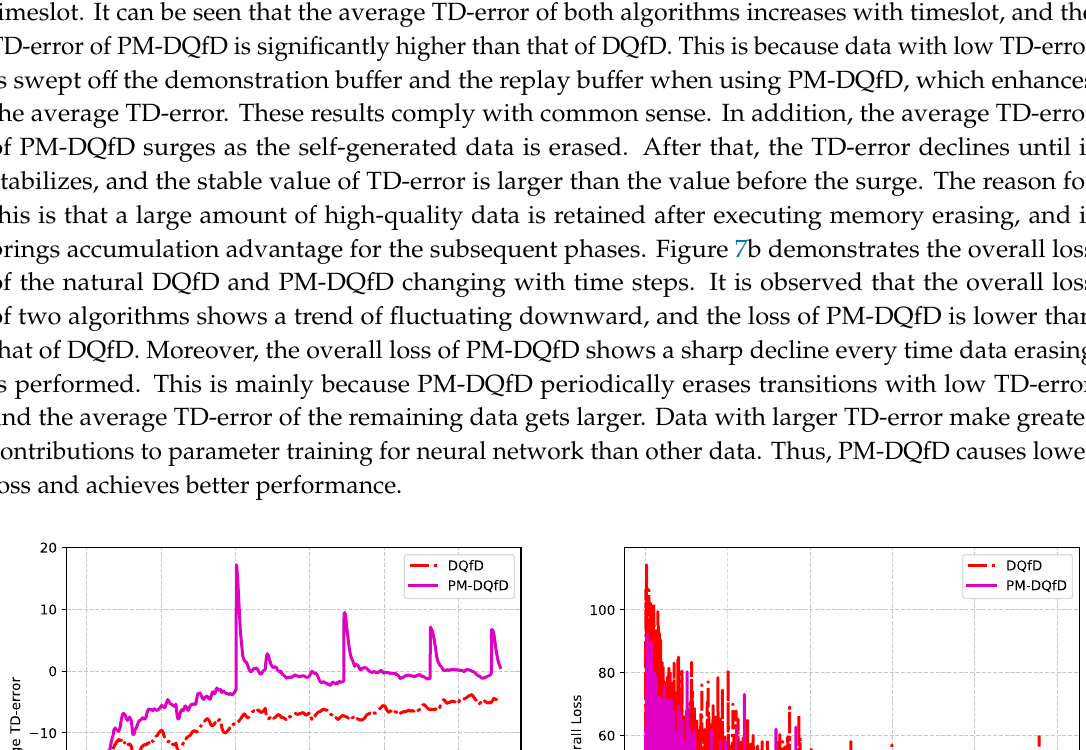
Figure 8. Expected reward versus number of episodes. The effectiveness properties of the energy efficiency and routing latency are investigated in Figure 9. In Figure 9a, we depict the system power consumption ratio changing with the number of episodes. For all algorithms, system PCR experiences a gradual decline as the learning process goes on. From these curves, it can be concluded that the DQfD-based routing protocols achieve lower energy expenditure and faster learning speed than PM-DQN, DQN and CRQ-routing. Moreover, the single-agent framework, DQfD-based schemes have almost the same convergence speed as the